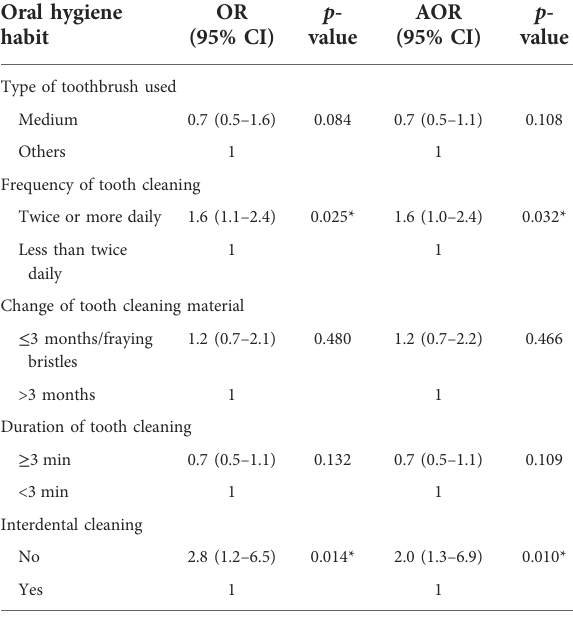
TABLE 5 Multivariate analysis of oral hygiene habits and OHRQoL. Oral hygiene